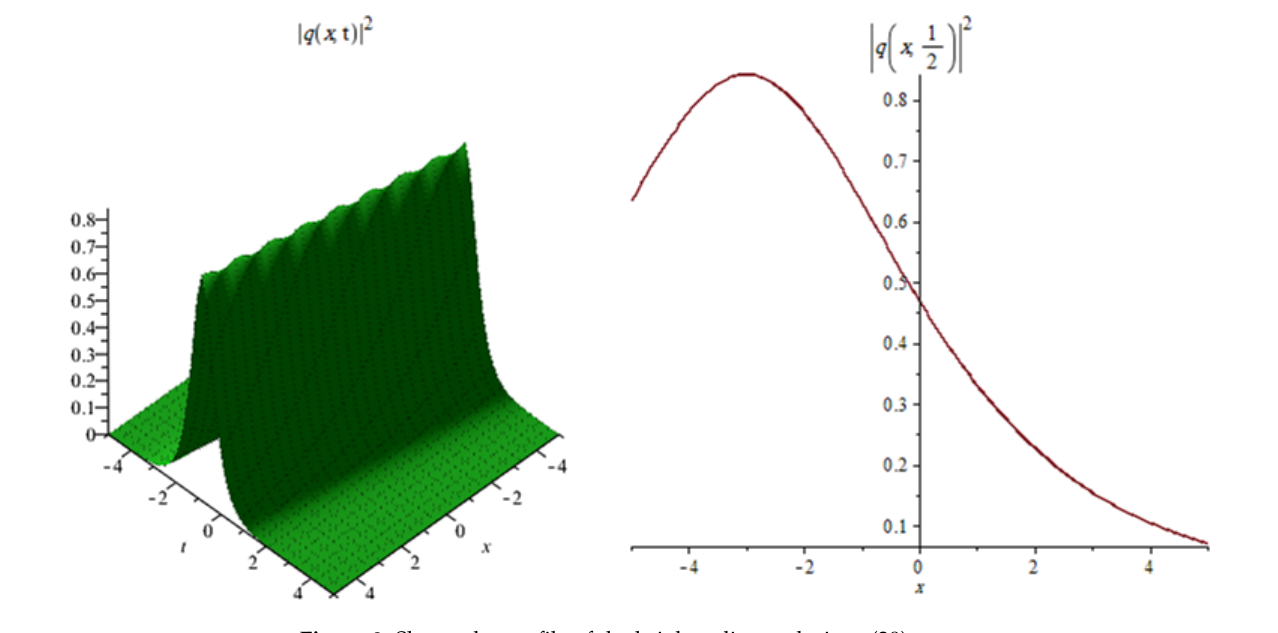
Figure 8. Shows the profile of the bright soliton solutions (29). Figure 9: The numerical simulations of the solutions (29) 3D and 2D (with t = 1 with the parameter values a 1 = 1, a 2 = 1, b = 1, σ = 2, α = 2, κ = 1 10, 5 5. c = 5, v = x , t − − ≤ ≤